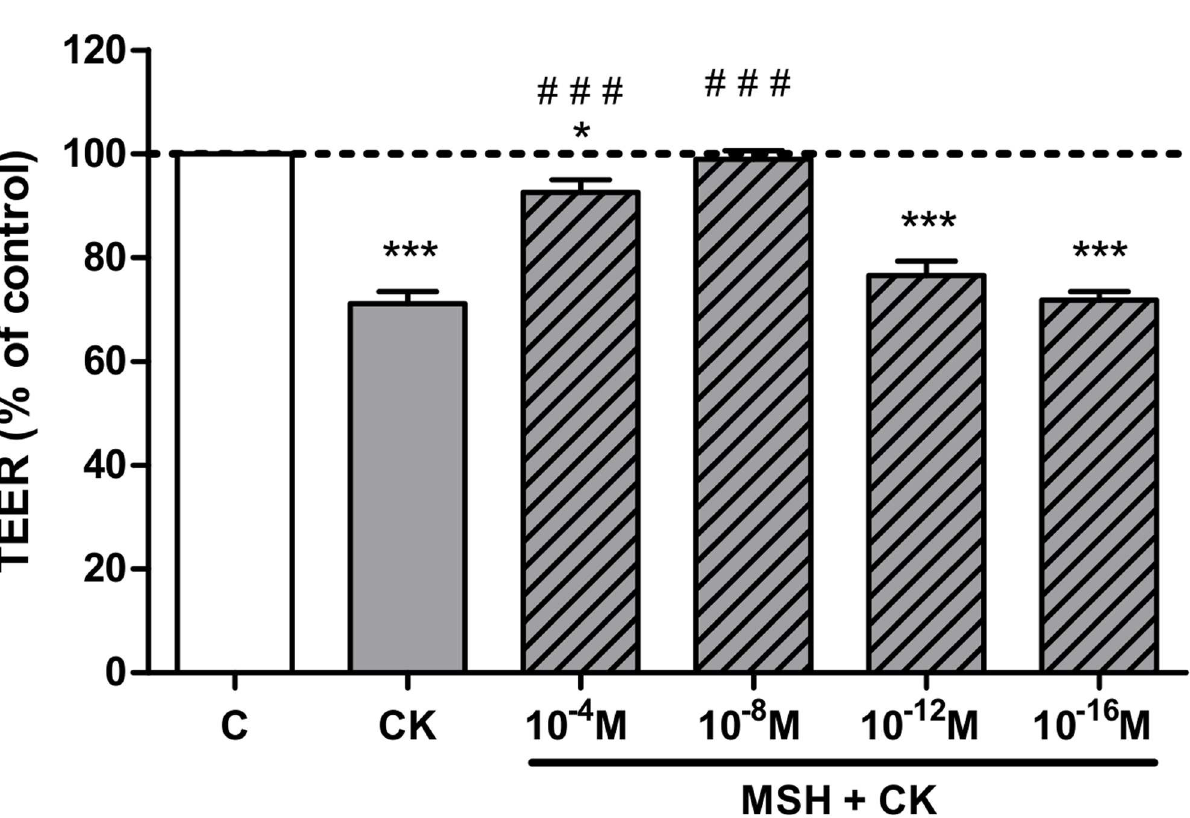
Fig 2. The effect of different concentrations of α -MSH on the electrical resistance of cytokine treated Caco-2 monolayers. Caco-2 monolayersgrown on culture inserts were treated with cytokines (CK; 50 ng/ml TNF- α and 25 ng/ml IL-1 β ) without or with different concentrations of α -MSH (10 − 4 M, 10 − 8 M, 10 − 12 M, and 10 − 16 M) for 24 hours. The control group (C) received culture medium. Transepithelial electricalresistance(TEER) values are shown as percentage of untreatedcontrol. Means ± S.D., n = 3; *** P < 0.001, * P < 0.05, ### P < 0.001. * : CK, CK+MSH compared to C; # : CK+MSH comparedto